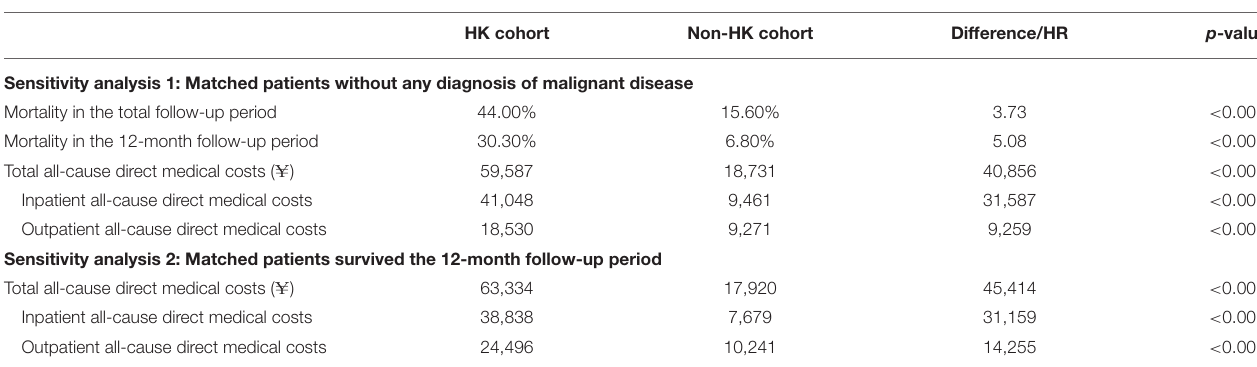
TABLE 4 | The results of sensitivity analysis. HK cohort Non-HK cohort Difference/HR p -value